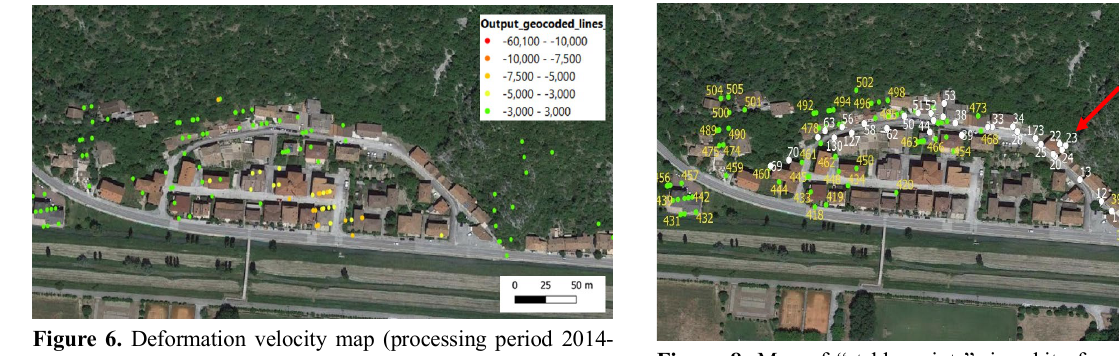
Figure 8. Map of “stable points”, in white from topographic levelling (reference points are indicated by the red arrow) and in green from